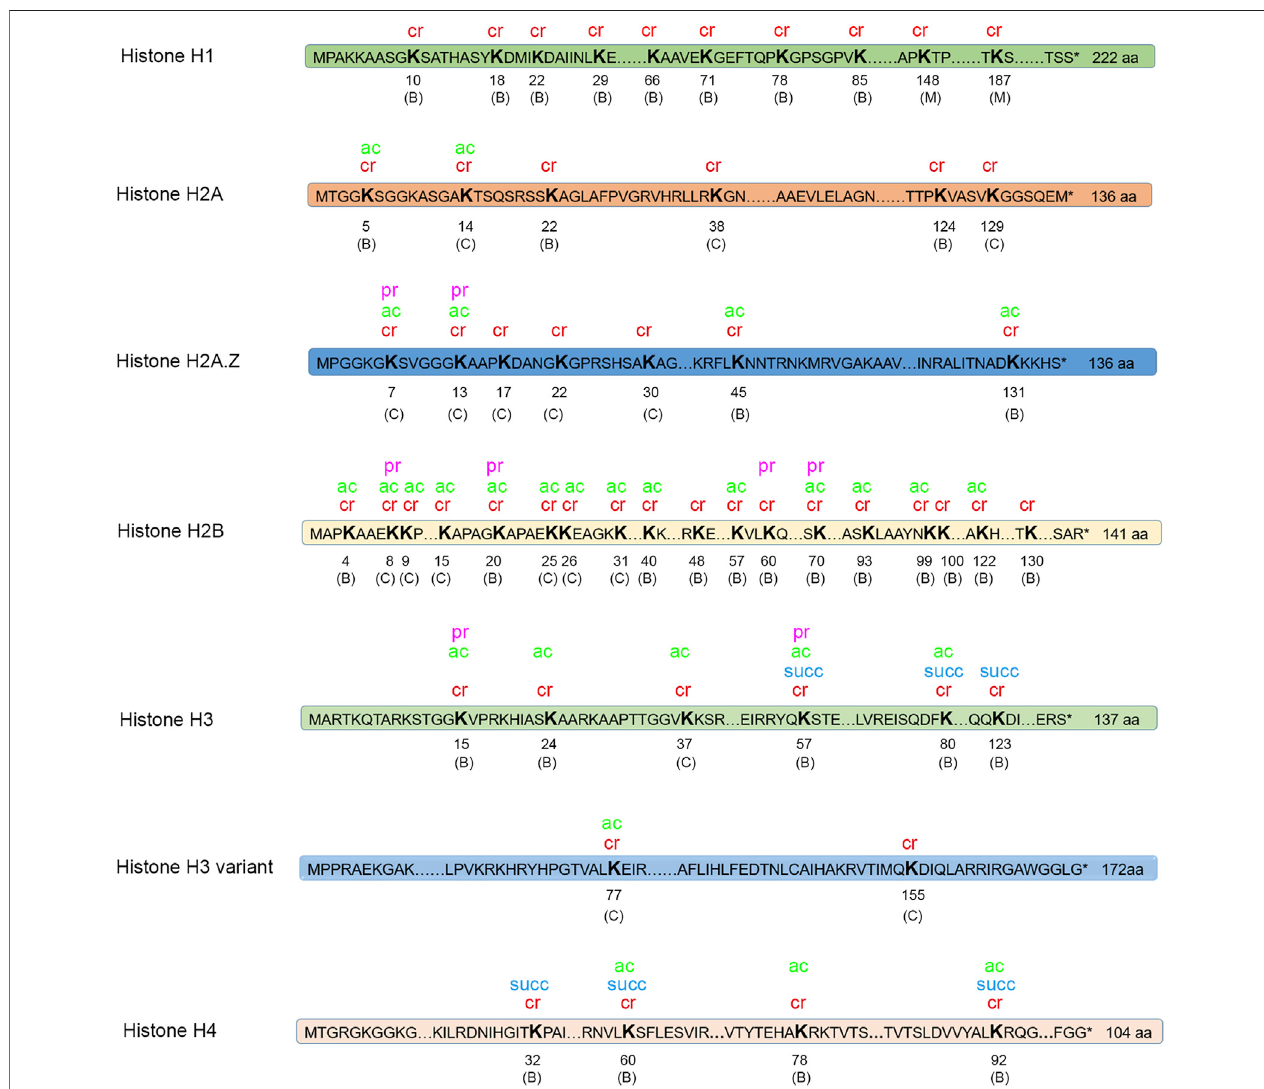
FIGURE 6 | Modi fi cations on histones. Four types of modi fi cation were identi fi ed on histones. Cr, crotonylation; ac, acetylation; pr, propionylation; succ, succinylation. “ C ” in parentheses indicates the site is only crotonylated in conidia; “ M ” in parentheses indicates that the site is only crotonylated in mycelia; “ B ” in parentheses indicates that the site is crotonylated in both conidia and